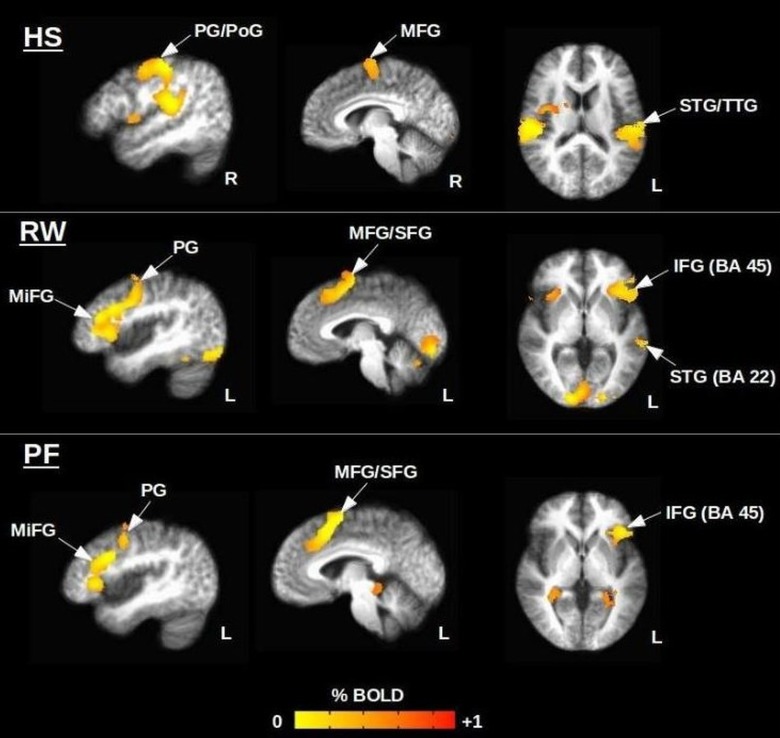
Healthy control group maps (n = 12) for the Hand Squeezing (HS), Rhyming Words (RW), and Phonemic Fluency (PF) tasks.Peak coordinates are provided in Table 2. Abbreviations: PG, PoG = precentral, postcentral gyrus; SFG, IFG, MiFG, MFG = superior, inferior, middle, medial frontal gyrus; STG, TTG = superior, transverse temporal gyrus. BA = Brodmann area.